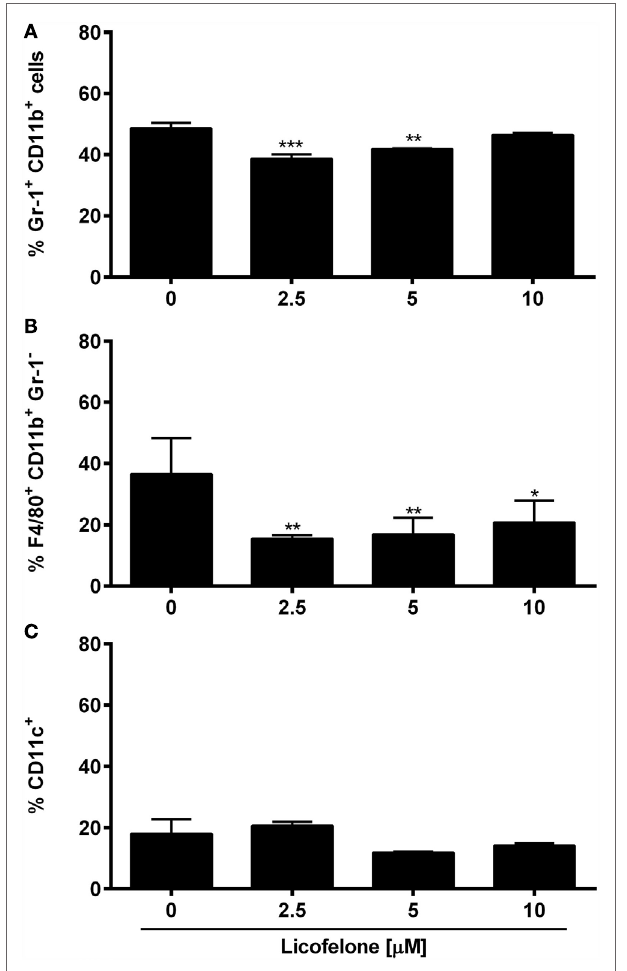
FigUre 5 | licofelone affects the generation of iMcs and macrophages in vitro . BM cells were harvested from the femur of naive C57BL/6 mice and were incubated with media and GM-CSF (20 ng/mL), PGE 2 (9.1 μ g/mL), and licofelone (2.5, 5, and 10 μ M) for 5 days. The frequency of (a) Gr-1 + CD11b + IMCs, (b) Gr-1 − F4/80 + macrophages, and (c) CD11c + DCs was determined by flow cytometry. Frequencies are shown as a percentage of live cells (PI low cells). The results are the mean + SD of three independent experiments ( n = 2/experiment). *** p < 0.001, ** p < 0.01, * p <